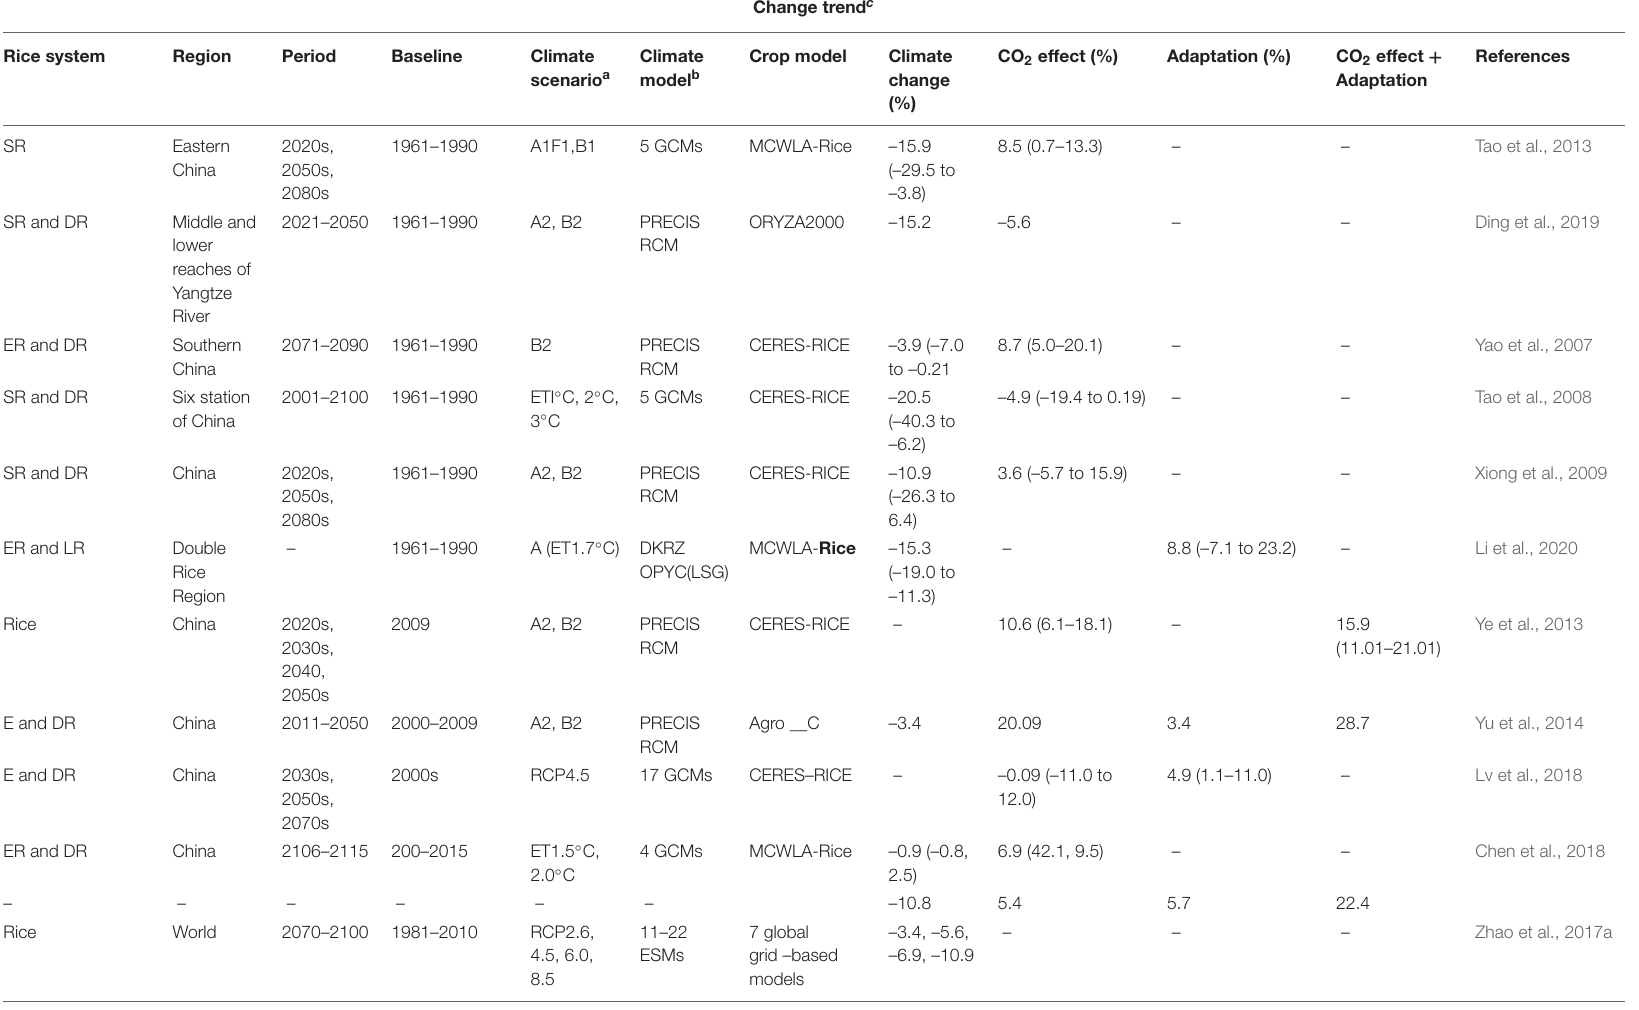
TABLE 2 | Impact of future climate change on rice grain